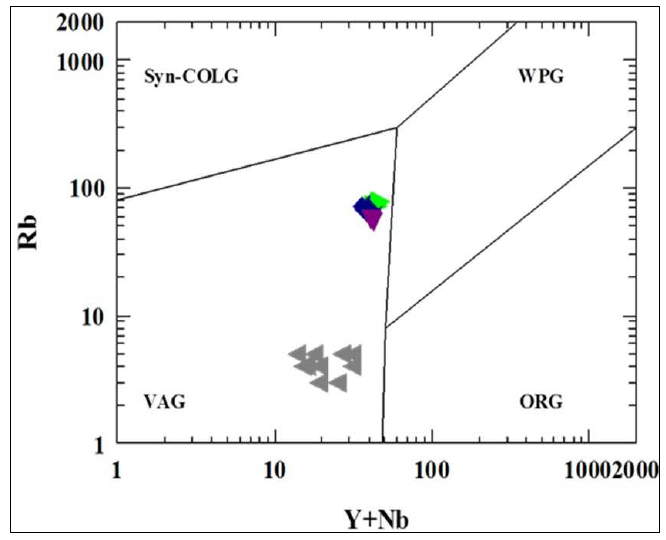
Figure 6. Rb–(Y + Yb) binary diagram [56]: VAG, volcanic arc granites; Syn-COLG, syn-collision granites; WPG, within plate granites; ORG, ocean ridge granites.